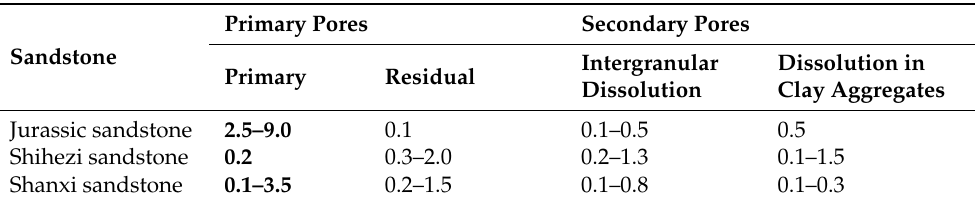
Table 1. Types and contents of intergranular pores in three layers of sandstone *.